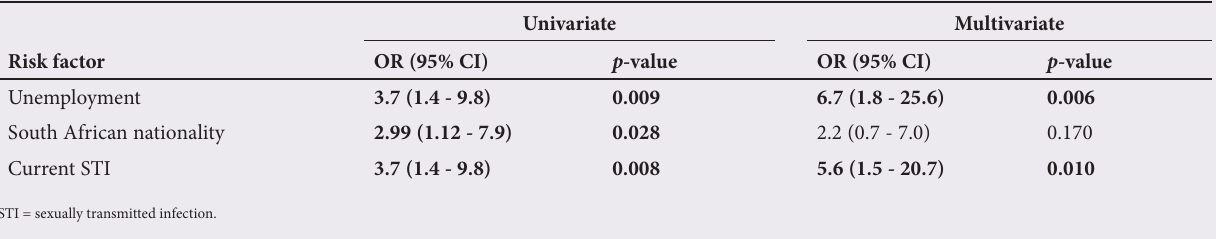
Table 2. Risk factors for HIV using logistic regression* Risk